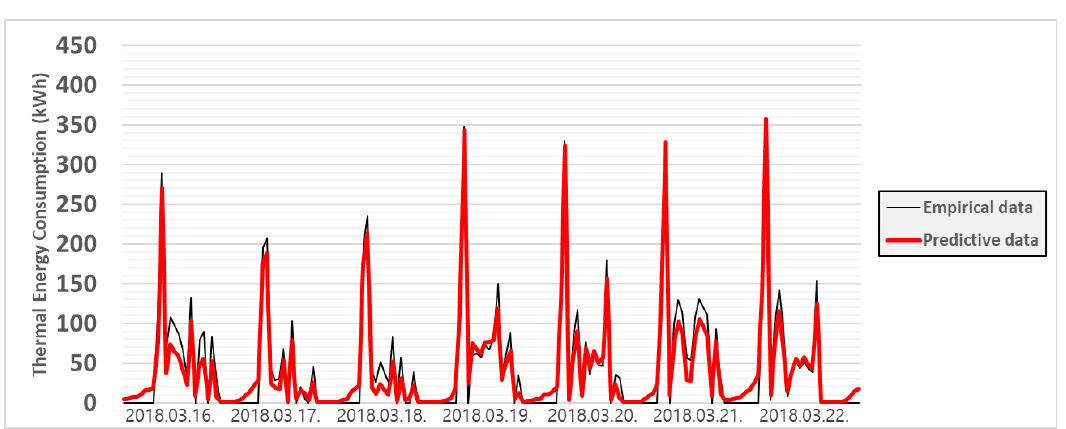
Figure 10. Case 1: Comparison between empirical and predictive data.